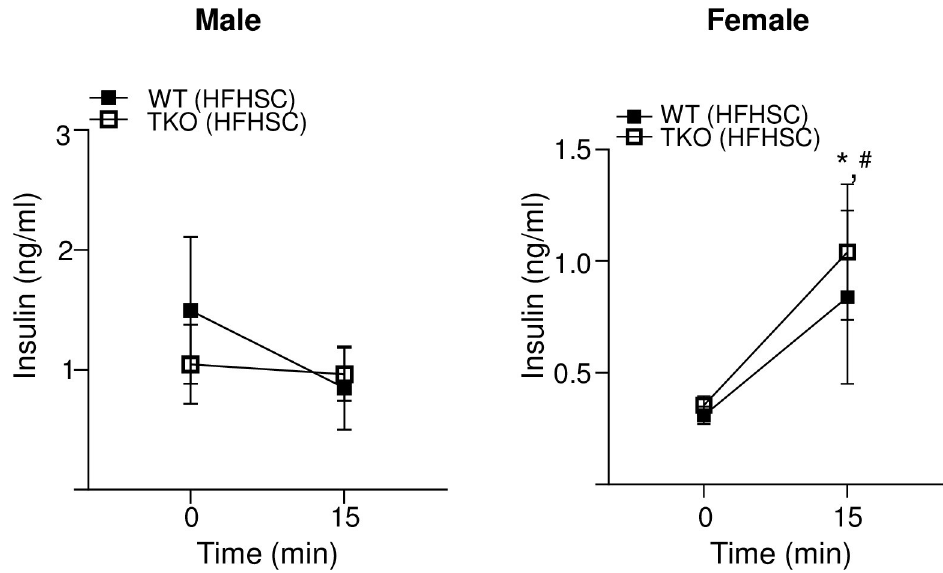
Fig 6. Deficiency of SAA does not affect glucose stimulated insulin secretion. Plasma insulin levels in male (left panel) and female (right panel) mice before and 15 minutes after intraperitoneal glucose injection, the mice were fed HFHSC diet for 14 weeks and fasted for 16 h prior to the study. Data are mean ± SEM;. � and # = P � 0.05 between � WT chow and HFHSC diet and # between TKO chow and HFHSC diet.